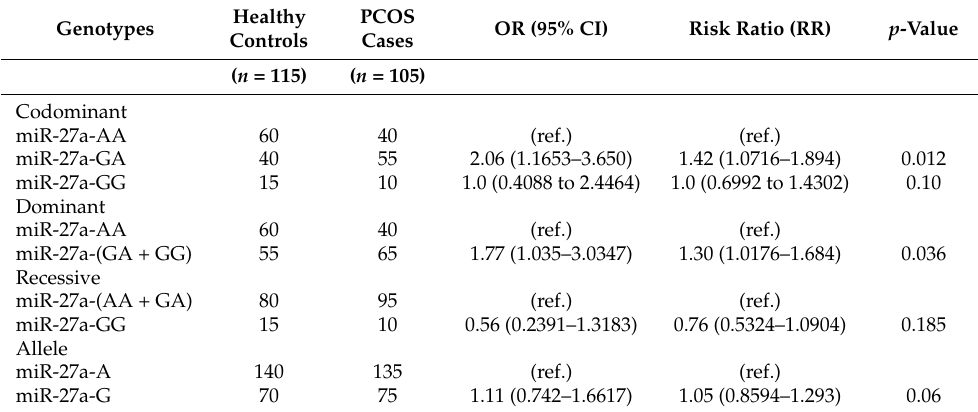
Table 6. Association of miR-27a rs895819 A > G gene variations with PCOS susceptibility.